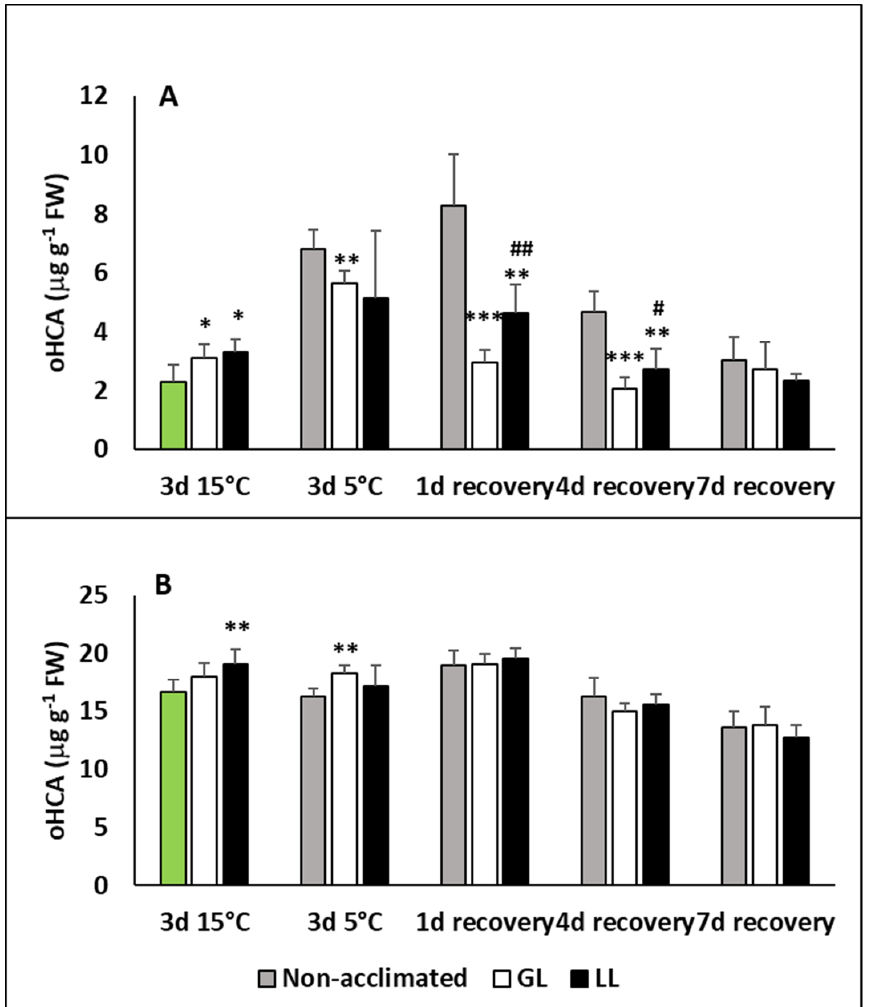
Figure 2. Changes in the ortho-hydroxycinnamic acid (oHCA) contents during cold acclimation (15/13 °C), chilling (5 °C) and recovery in the leaves and roots of young maize plants: control plants (22/20 °C, 387 µmol m −2 s −1 ). Light intensities during hardening: GL: 387 µmol m −2 s −1 ; LL: 107 µmol m −2 s −1 . *, **, *** significant differences compared to the control plants on the same day at the p < 0.05, 0.01 and 0.001 levels, respectively. # , ## significant differences compared to the GL plants on the same day at the p < 0.05, and 0.01 levels, respectively. ( A : free oHCA in the leaves; B : free oHCA in the roots).